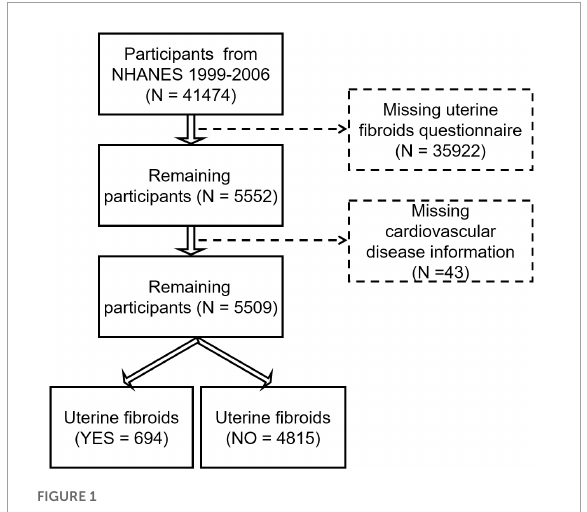
FIGURE1 The flowchart of sample selection criteria for the association between cardiovascular diseases (CVDs) and uterine fibroids.